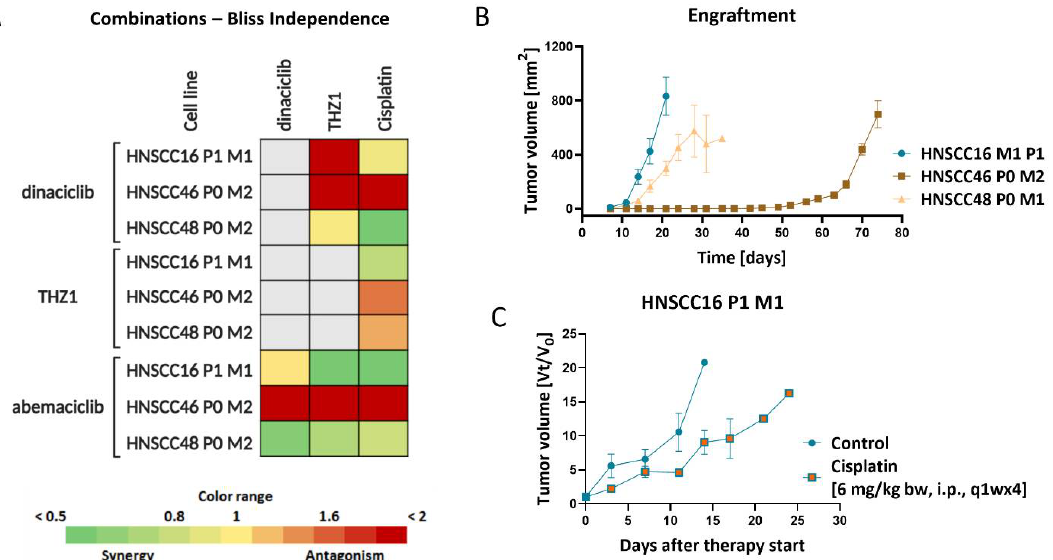
Figure 4. In vitro and in vivo drug response. ( A ) The Bliss Independence model was used to calculate potential synergistic or additive effects. The green color indicates a synergistic and red color indicates an antagonistic effect of the simultaneous combinations. Drug doses were applied for 2 × 72 h as follows: abemaciclib [HNSCC16 P1 M1/HNSCC46 P0 M2: 1 µM, HNSCC48 P0 M1: 0.1 µM],